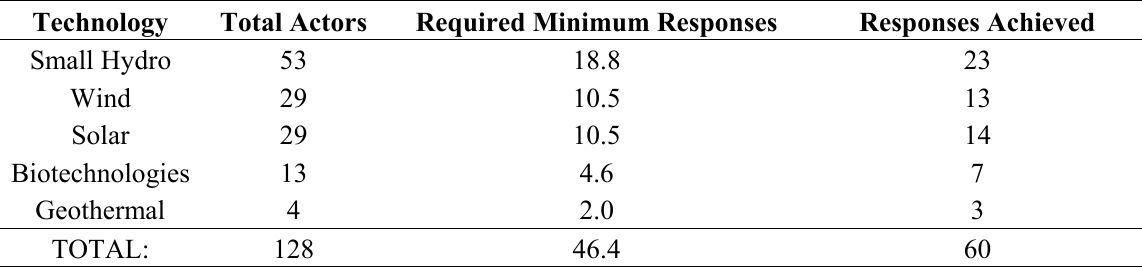
Table 3. Summary of respondents at the various renewable